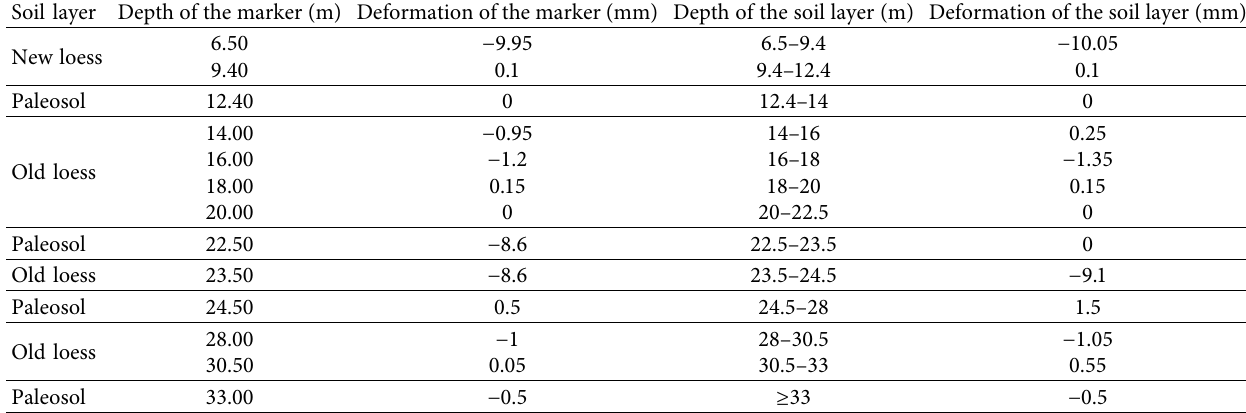
Table 4: Calculation table of deep subsidence of deep markers after correction.